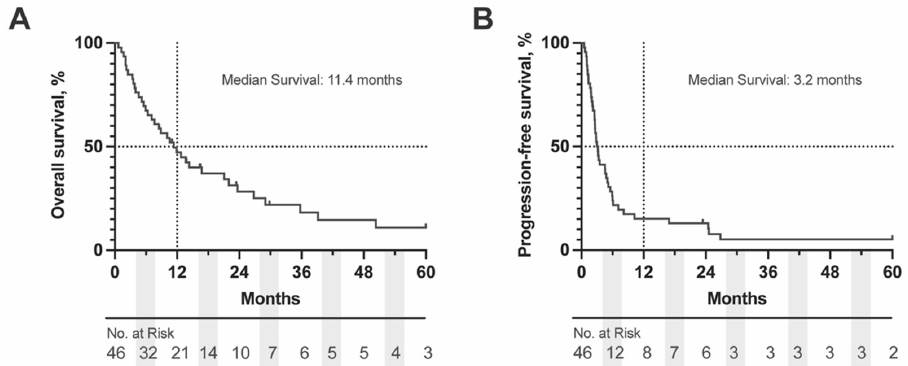
Figure 1. Kaplan-Meier (KM) Curve of ( A ) OS and ( B ) PFS for complete OM cohort. Dashed lines represent the 50% survival and 12 months, respectively. Number at risk is displayed below each graph in 6 months intervals. OS = overall survival, PFS = progression free survival.